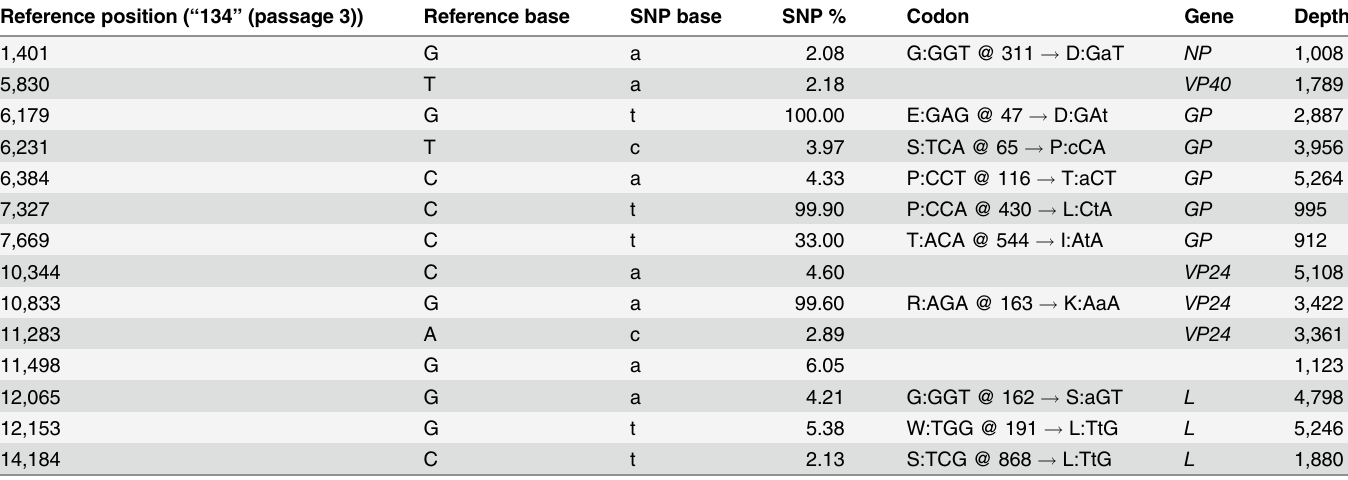
Table 2. Intrahost single nucleotide variants (iSNVs) of EBOV/Kik-9510621 “ R4414 ” (passage 2) comprising (cid:4) 2% of total population as compared to “ 134 ” (GenBank #AY354458). Reference position ( “ 134 ” (passage